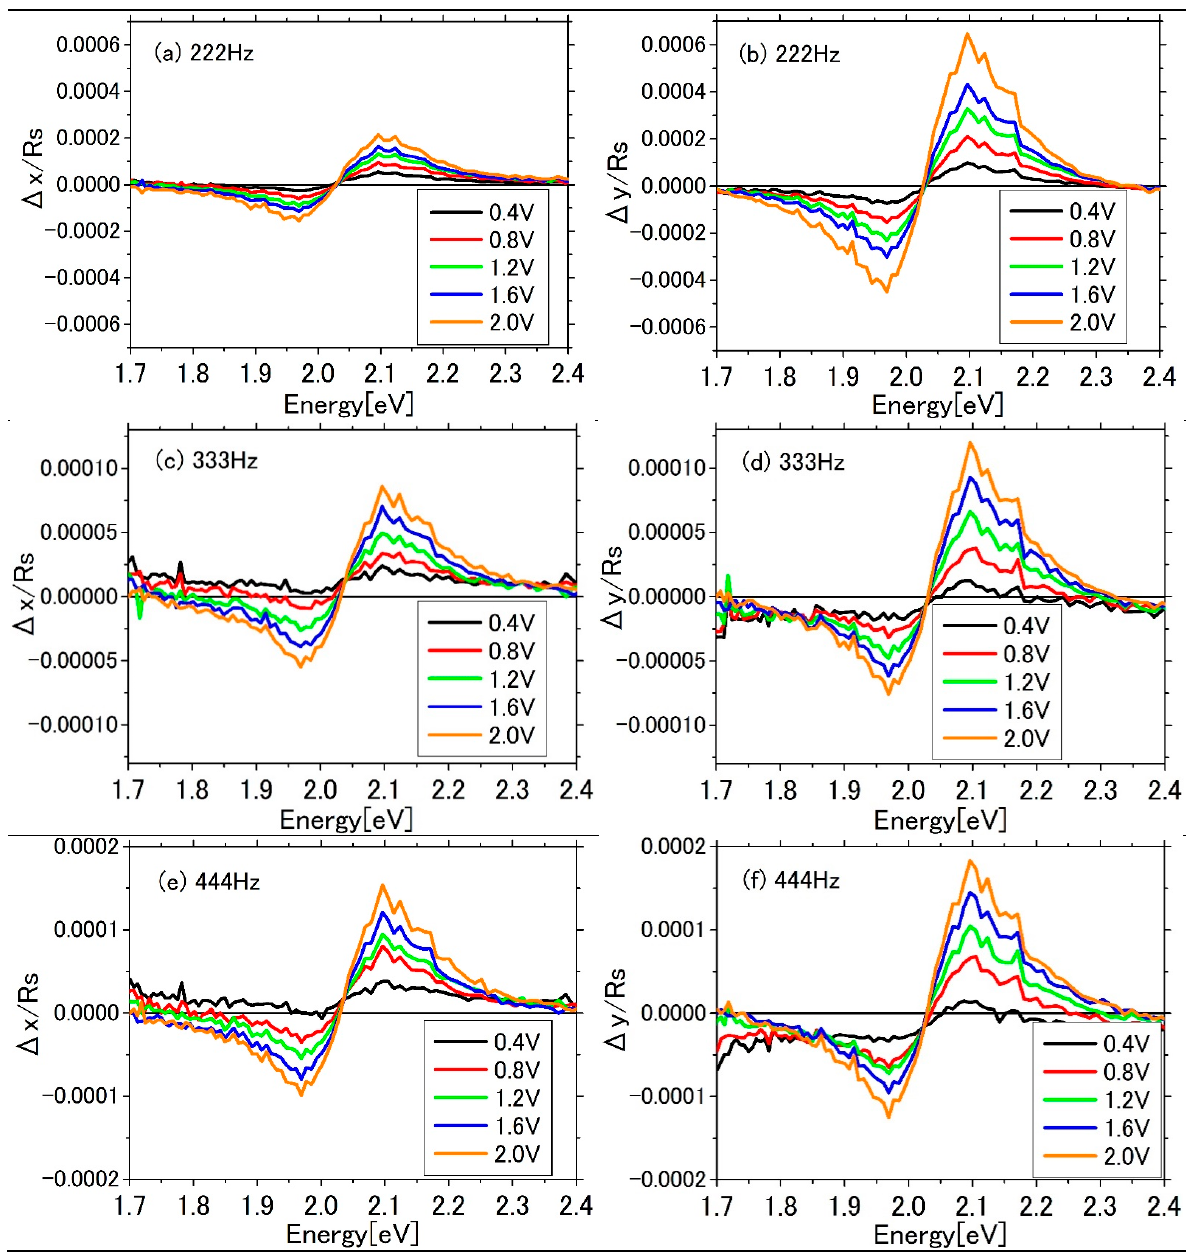
Figure 3. Normalized ele c tromodulation spectra ∆𝑋/𝑅𝑠 and ∆𝑌/𝑅𝑠 at 222 Hz, 333 Hz, and 444 Hz.